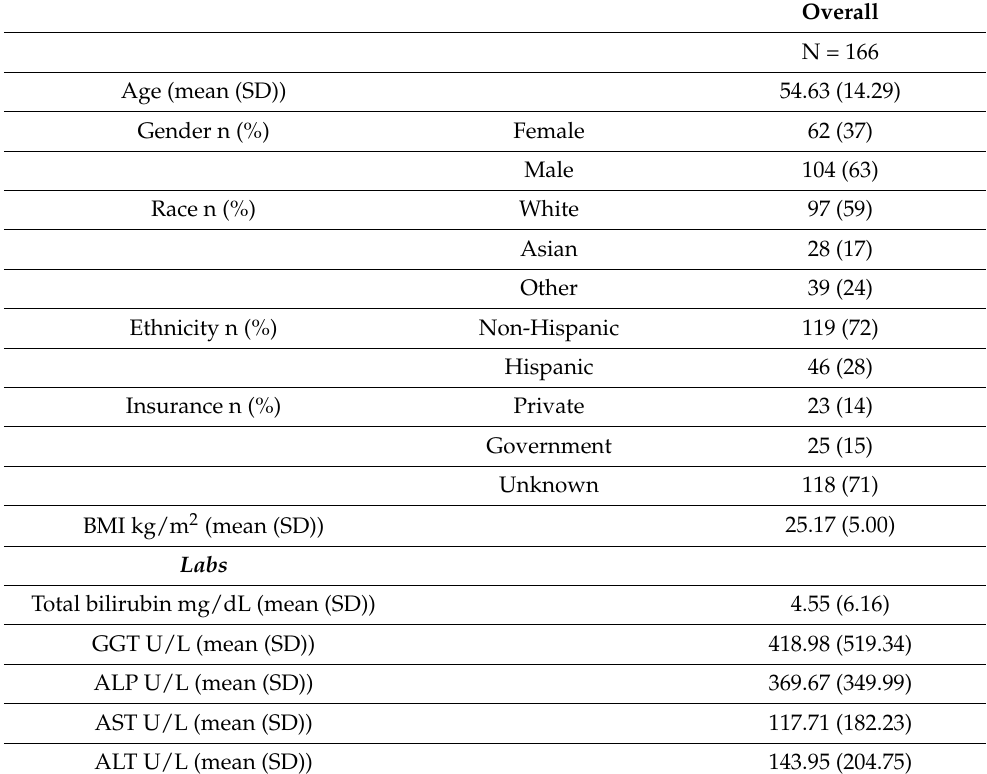
Table 1. Demographics and clinical characteristics of all adult patients with large duct obstruction on liver biopsy.